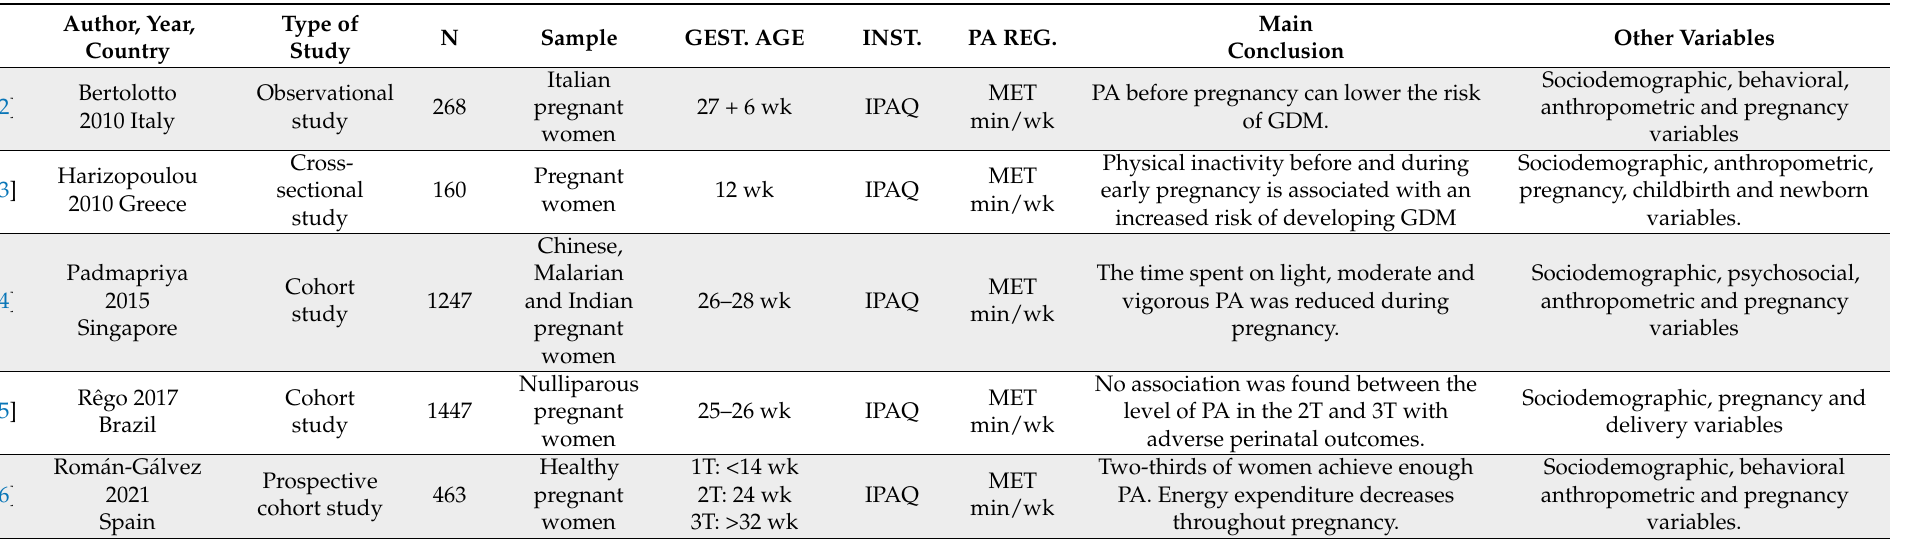
Table 4. Record of Physical Activity using the IPAQ questionnaire during